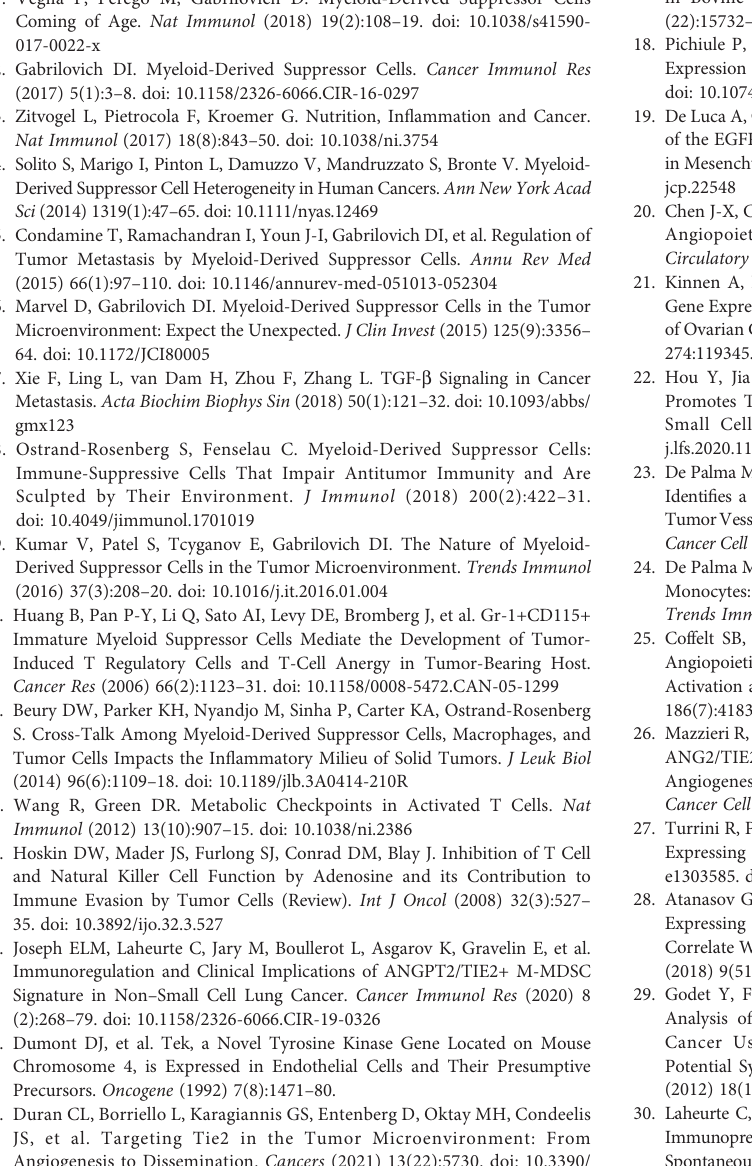
Supplementary Figure 2 | Correlation between TIE-2 + M-MDSC/ANGPT2 and anti-viral T cell responses in melanoma patients. (A) TIE-2 + M-MDSCs percentage according to antiviral T cells response negative (NEG) or positive (POS) in localized stage (I-II) (right) and in advanced stage (III-IV) (left) (Student T test *p <0,1). (B) ANGPT2 concentration according to antiviral T cells response negative (NEG) or positive (POS) in localized stage (I-II) (right) and in advanced stage (III-IV) (left) (Student T test * p <0,1). (C) TIE-2 neg M-MDSCs percentage according to antiviral T cells response negative (NEG) or positive (POS) in localized stage (I-II) (right) and in advanced stage (III-IV) (left) (Student T test *p <0,1)